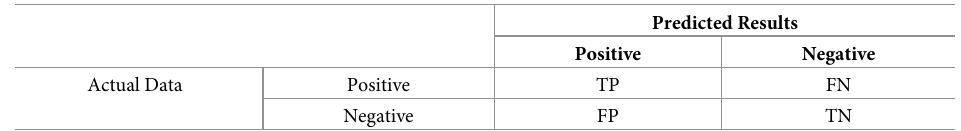
Table 4. Confusion